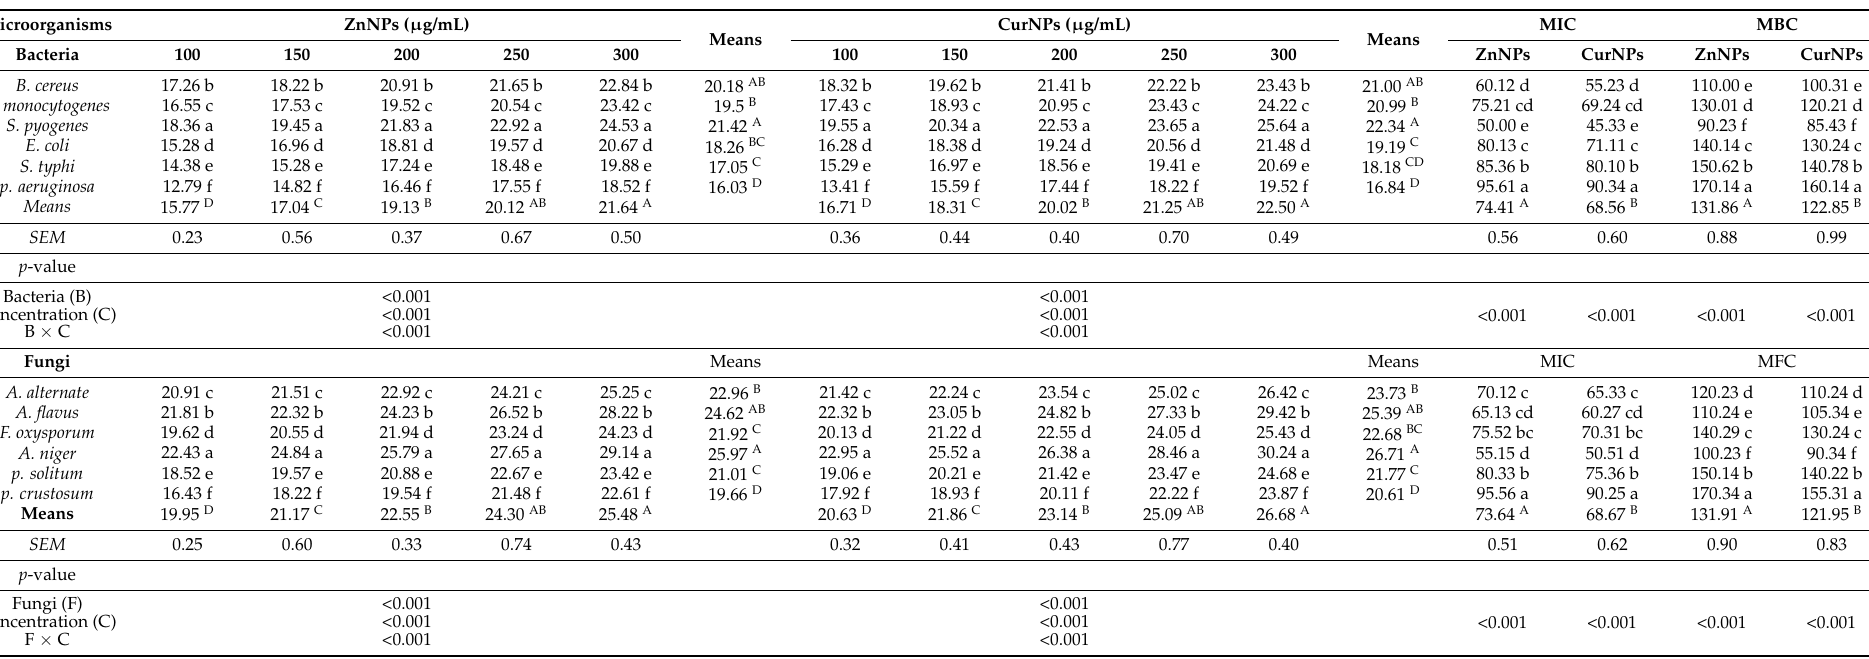
Table 2. Antimicrobial activity of ZnNPs and CurNPs against the tested bacteria and fungi represented by the inhibition zones diameters (mm), MIC, MFC and MBC ( µ g/mL). ( n = 6). Microorganisms Bacteria